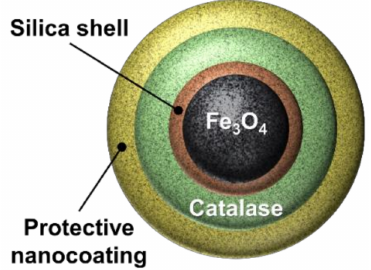
Figure 55. An immobilized enzyme at the surface of magnetic Fe 3 O 4 @silica core-shell nanoparticles (NPs) with a protective